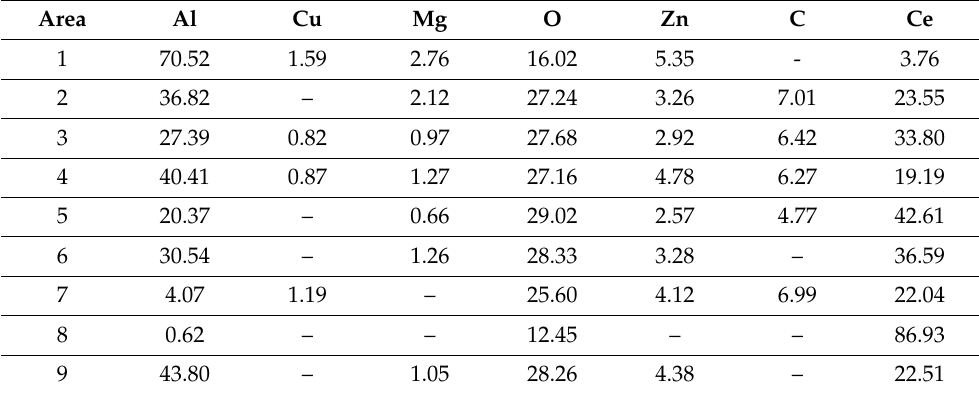
Figure 2. SEM images of 7075 samples: ( a ) 7-Ce-1, ( b ) 7-Ce-5, ( c ) 7-Ce-10, and ( d ) 7-Ce-15. EDX analyses were acquired in the points (arrows) or areas (square) marked. Table 3. Semiquantitative EDX analyses (wt. %) in areas marked in Figure